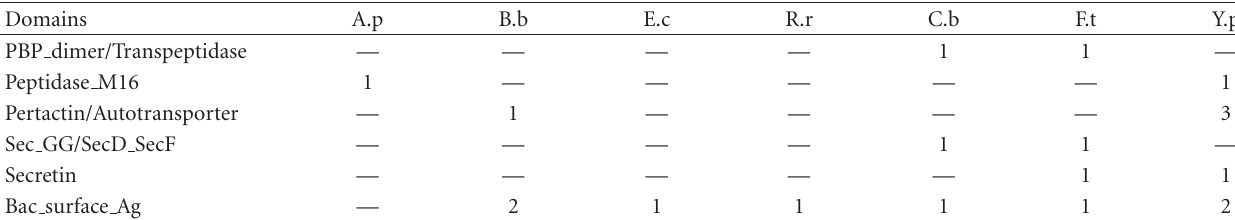
Table 5: Domains associated with sCFPs of at least 500 residues in length and present in more than one species of the indicated species of arthropod-borne Proteobacteria: A. phagocytophilum (A.p), B. bacilliformis (B.b), E. cha ff eensis (E.c), R. rickettsii (R.r), C. burnetii (C.b), F. tularensis (F.t), and Y. pestis